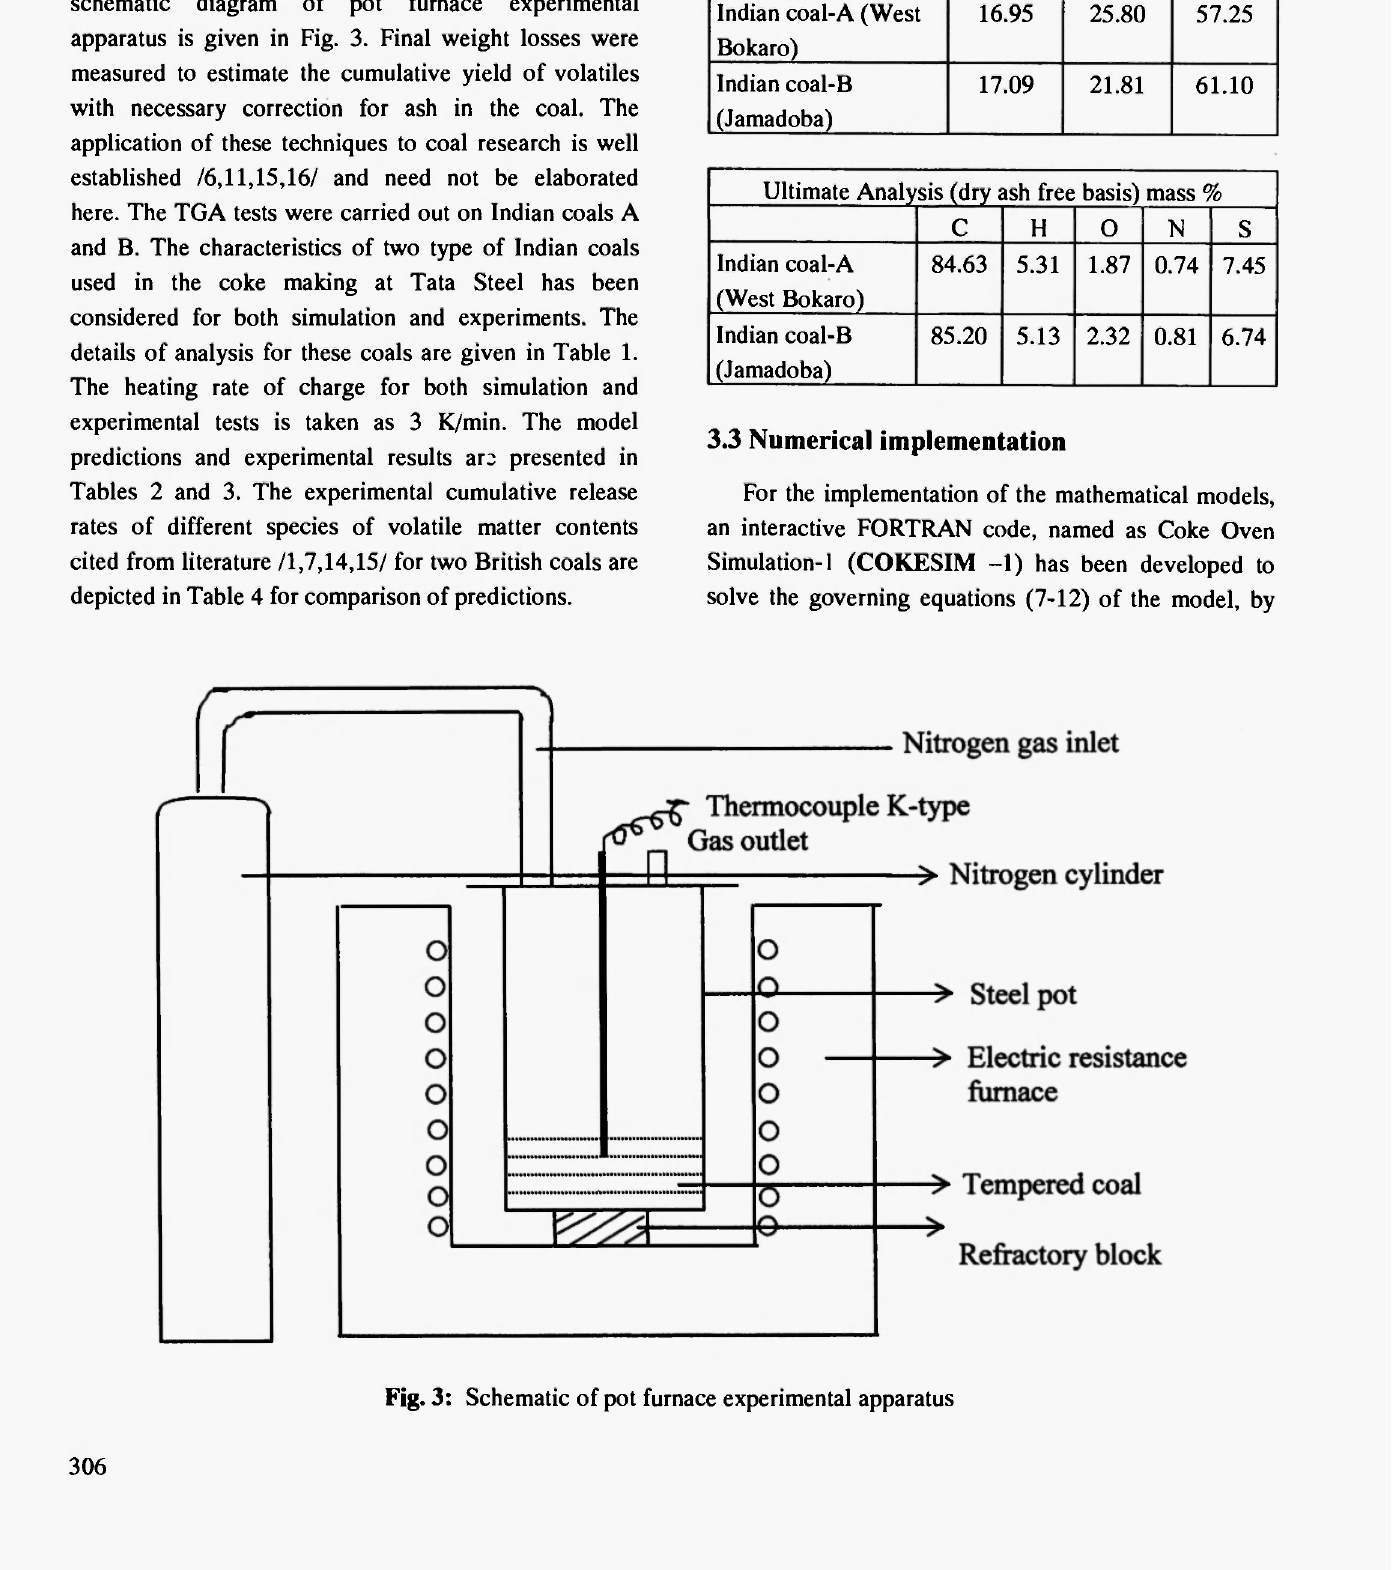
Fig. 3: Schematic of pot furnace experimental